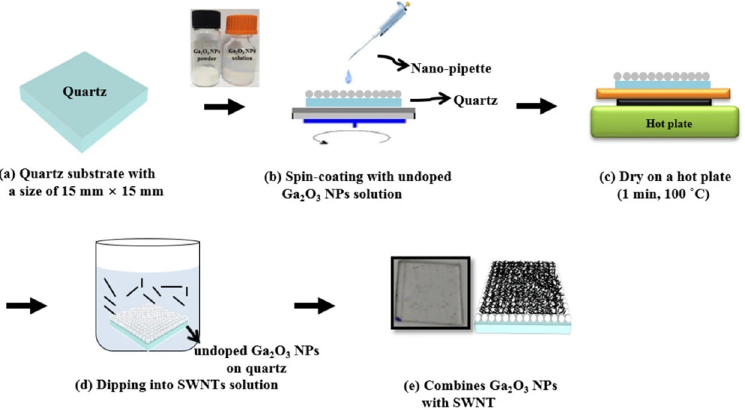
Figure 5. The schematic illustration for spin and dip-coating procedure of proposed Ga 2 O 3 - NP/SWNT layer on quartzes [41].